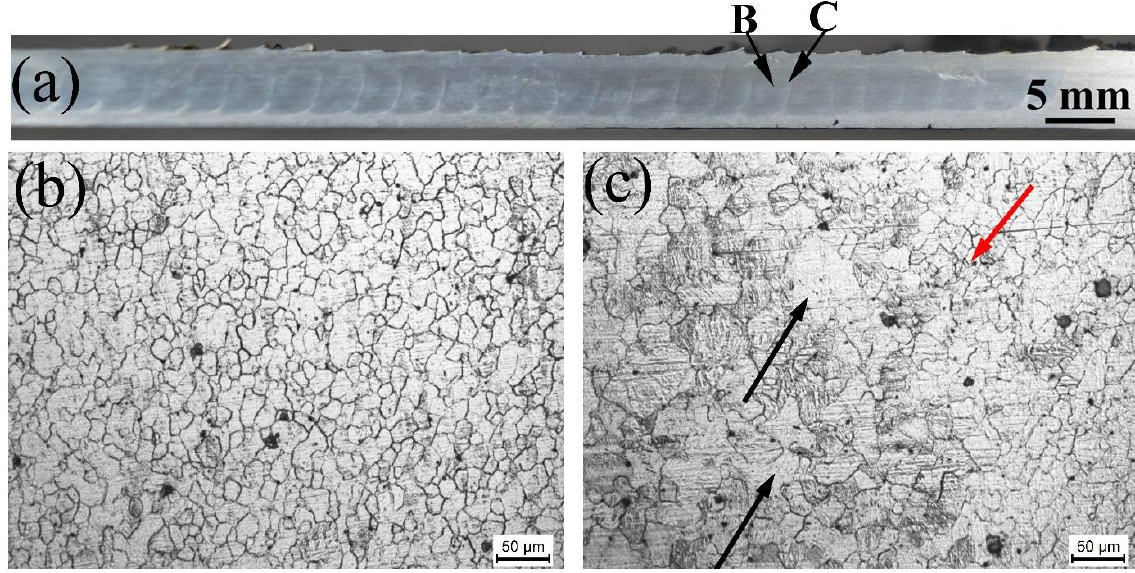
Figure 6. ( a ) A low-magnification macroscopic morphologies in the cross-section of M-FSP AZ61 alloy plate; optical micrographs at ( b ) Location B and ( c ) Location C in ( a ).